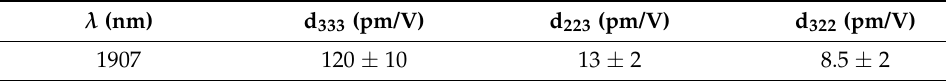
Table 16. NLO coefficients of OH1 [96].